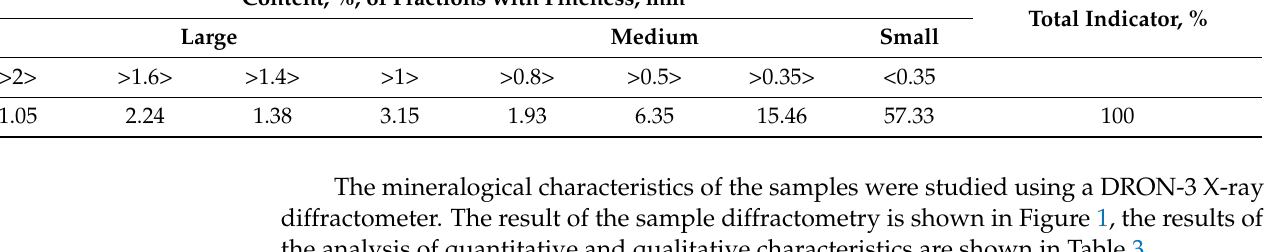
Table 2. Granulometric composition of the process sample.